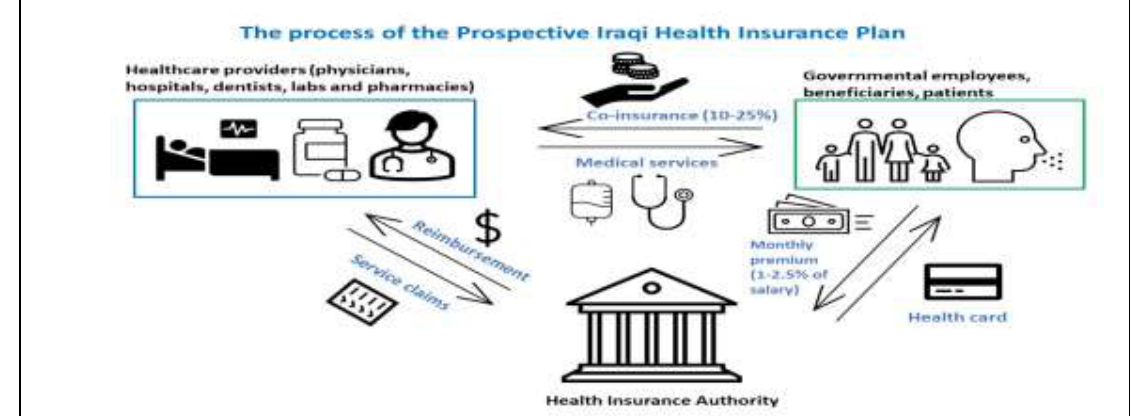
Figure 1. The prospective Iraqi Health Insurance